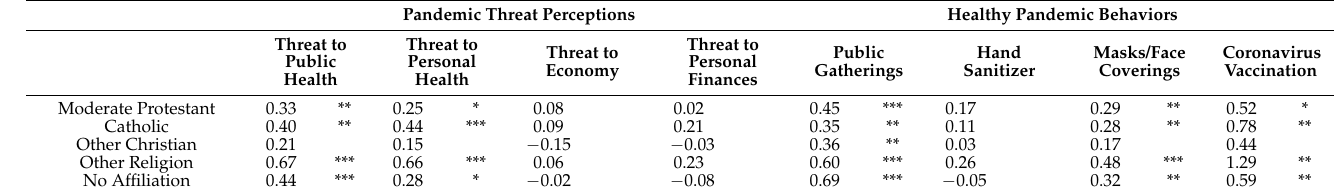
Table 3. Weighted regressions of pandemic threat perceptions and healthy pandemic behaviors (CHAPS